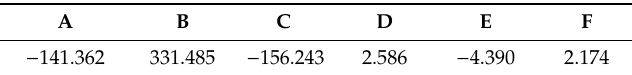
Table 3. Correlation Coe ffi cients for